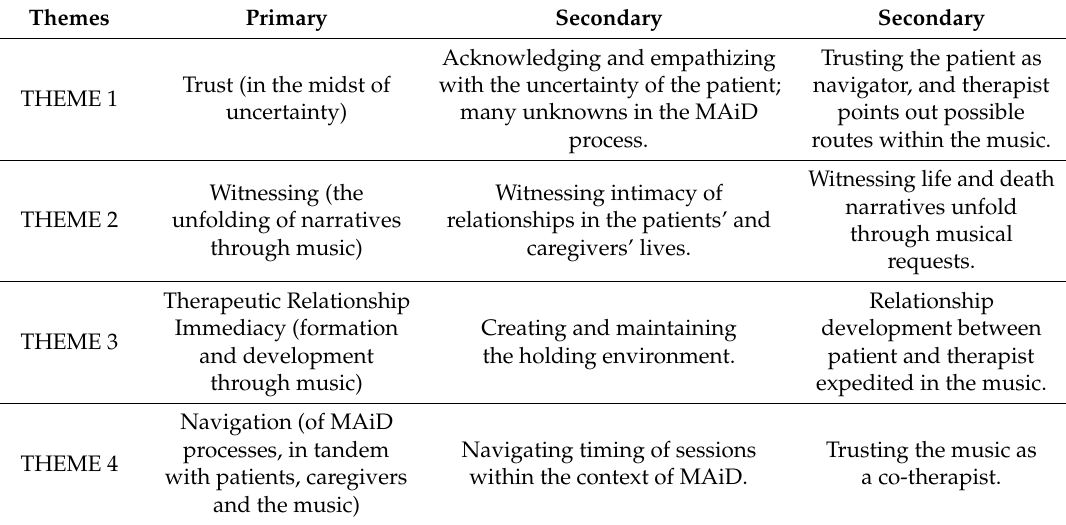
Table 4. Primary and secondary themes for the therapist /